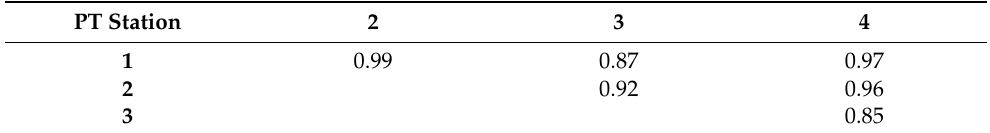
Table 7. Correlation of the displacement along the crest direction (X-axis) of all the possible couples of points.